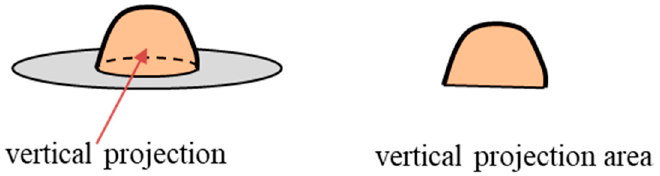
Figure 3. Vertical project schematic diagram.